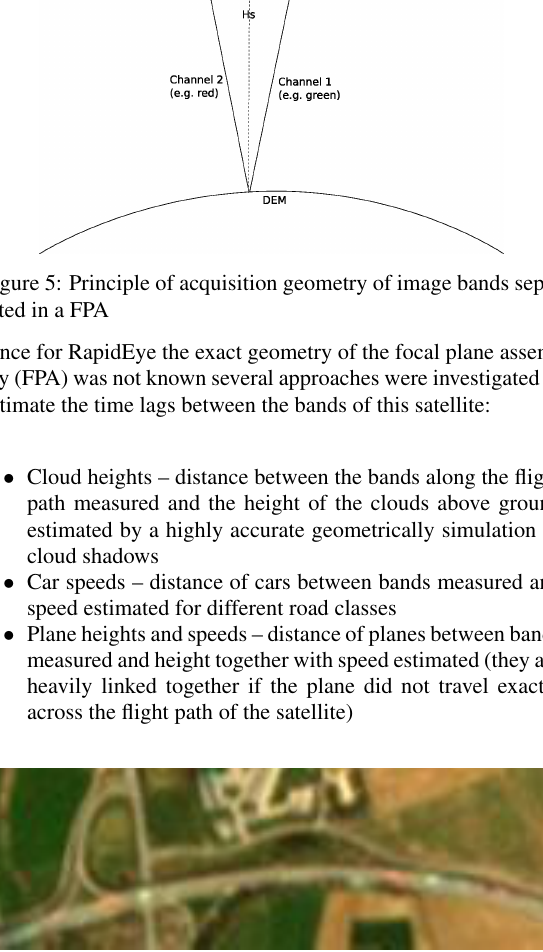
Figure 6: Example of moving cars in a RapidEye image (red and cyan dots on the roads)